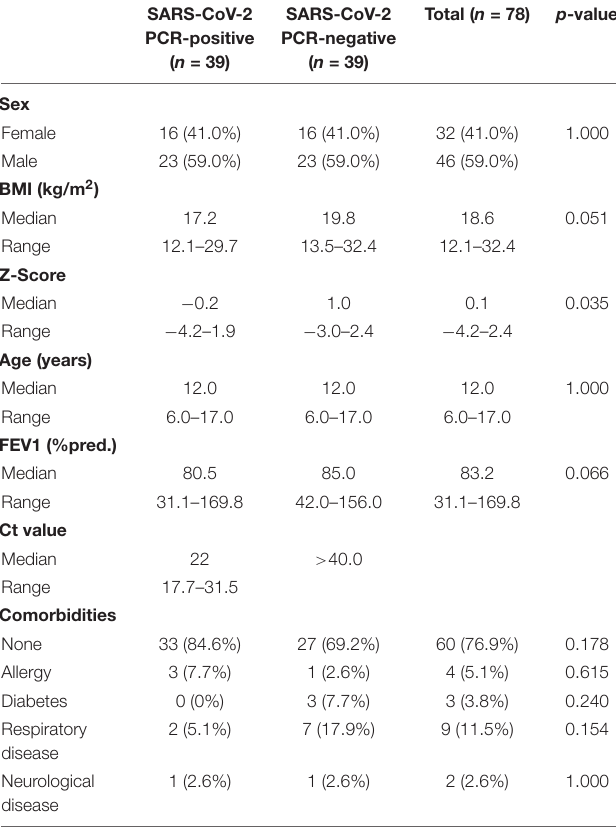
TABLE 1 | Characteristics of polymerase chain reaction (PCR) severe acute respiratory syndrome coronavirus 2 (SARS)-CoV-2 PCR-positive children and -negative age-matched